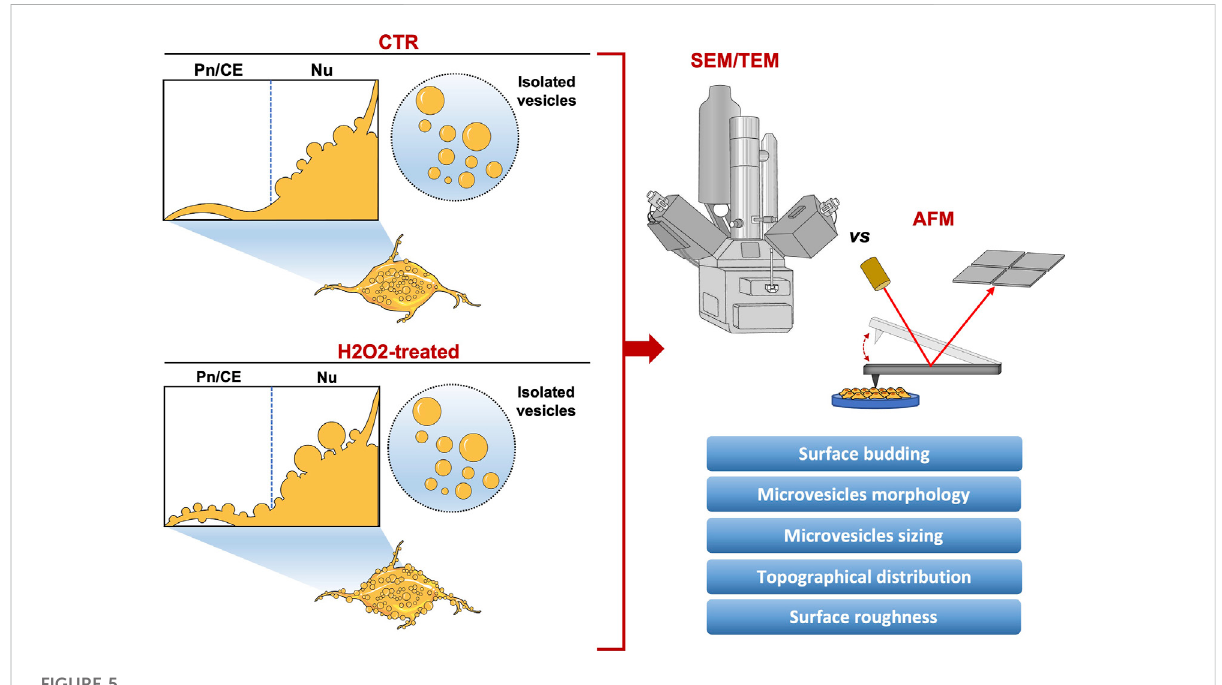
FIGURE 5 Graphical summary of the